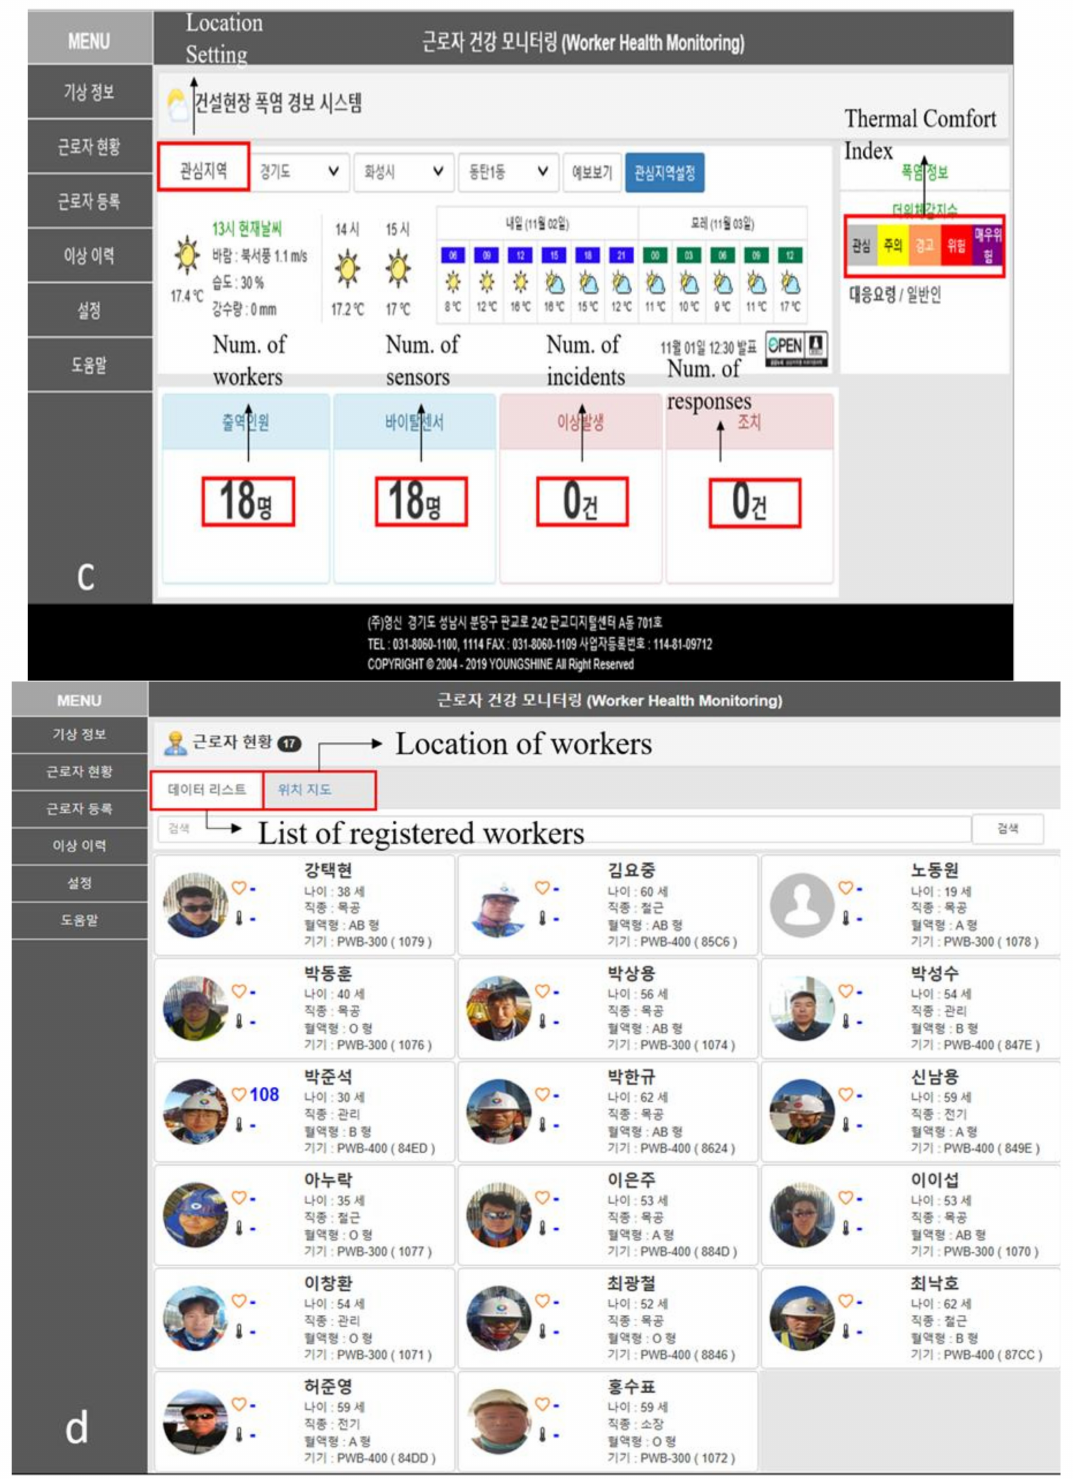
Figure 10. Web interface of the physiological monitoring platform: ( a ) Heartbeat rate monitoring page, ( b ) worker registration page along with the features of the monitoring platform, ( c ) the main page of the platform, and ( d ) physiological status of the registered workers in a